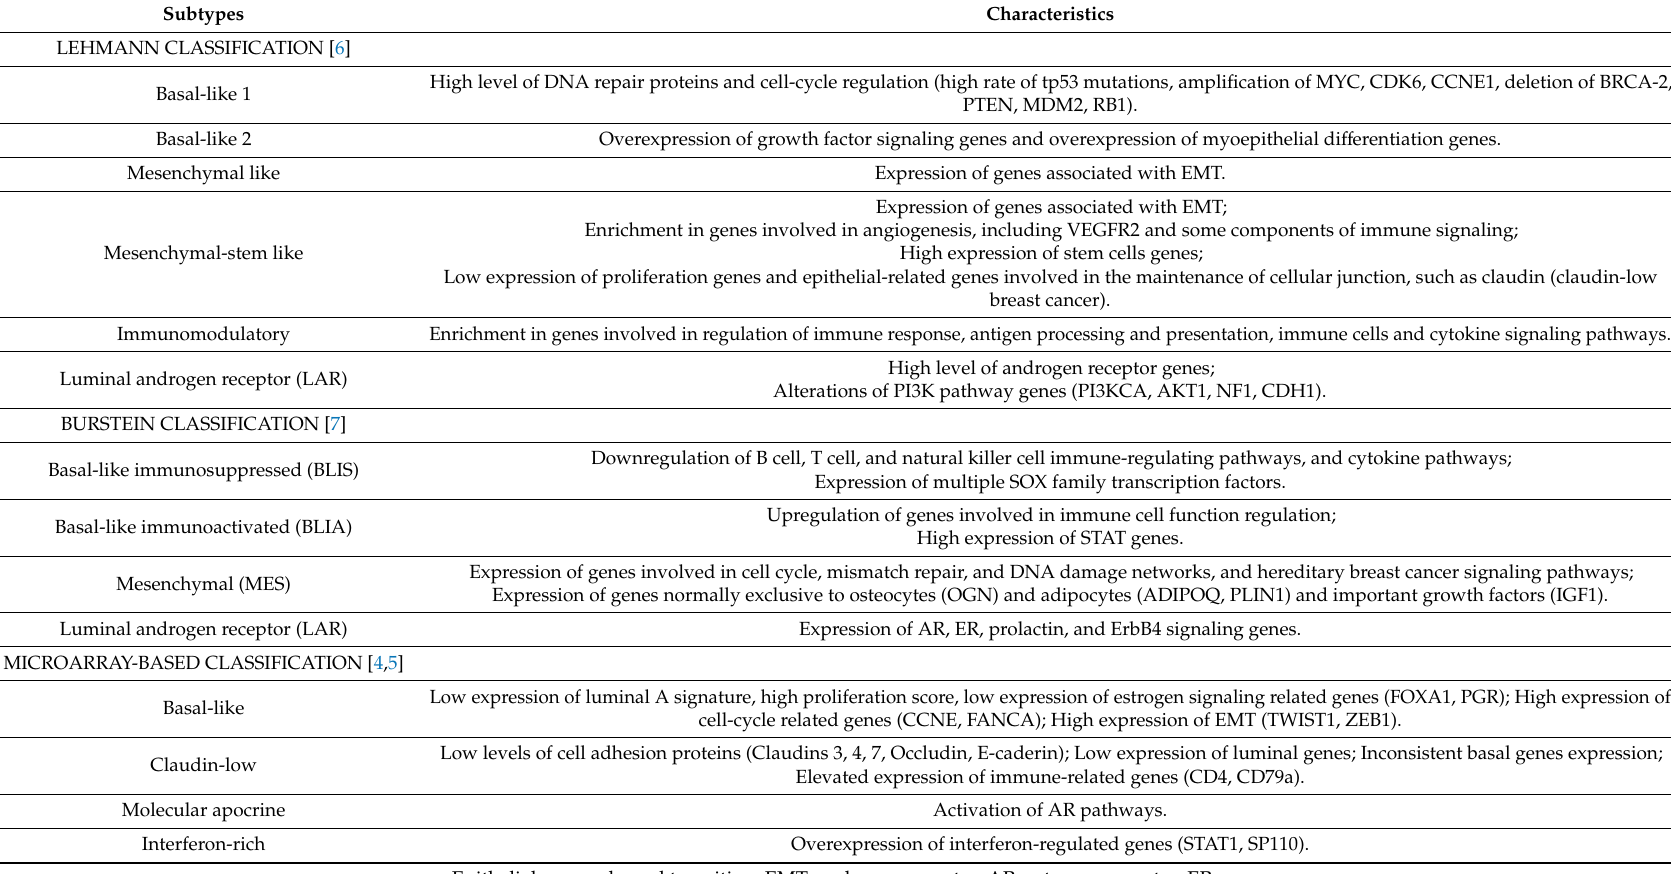
Table 1. Classifications of triple negative breast cancer